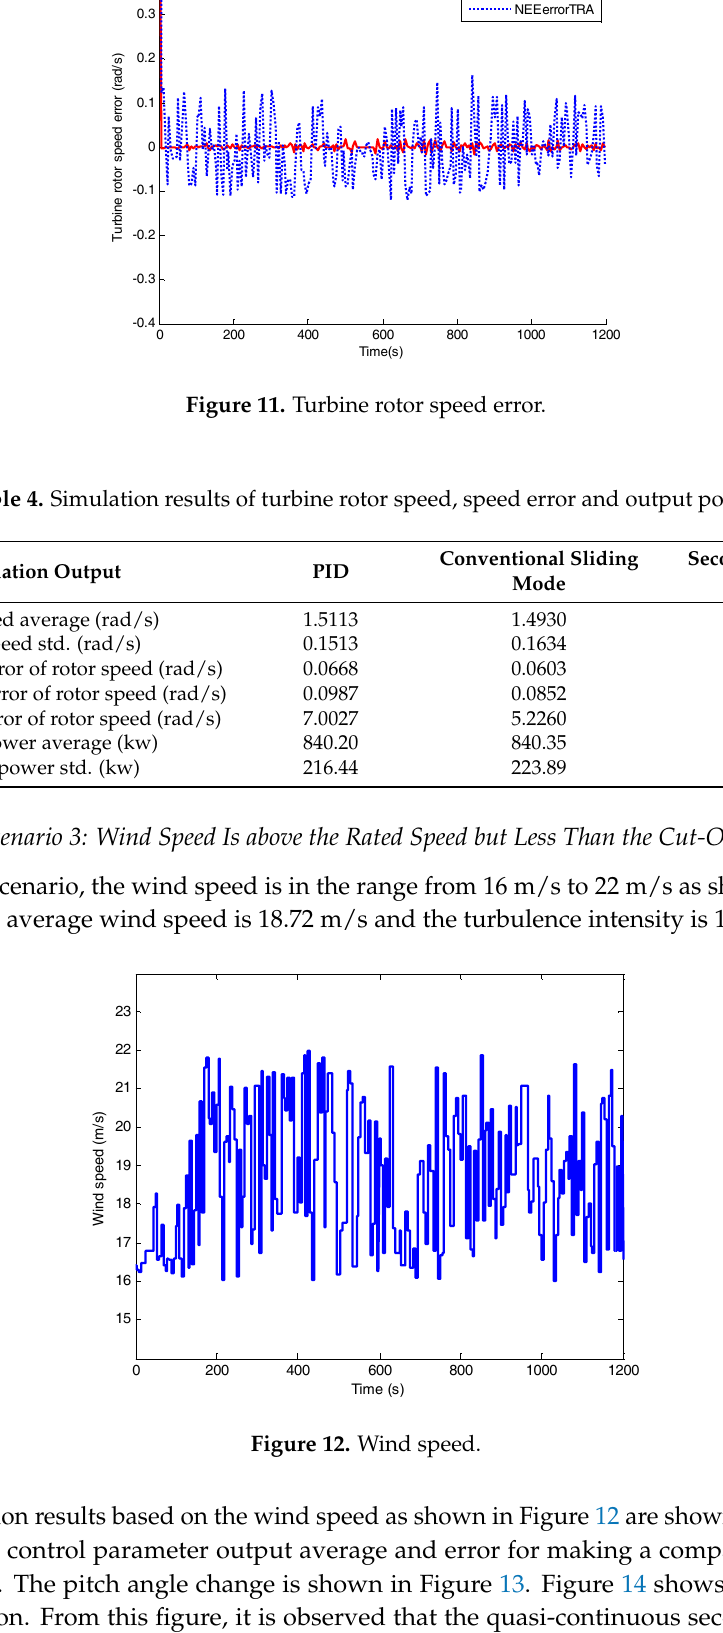
Figure 10. The turbine rotor speed.